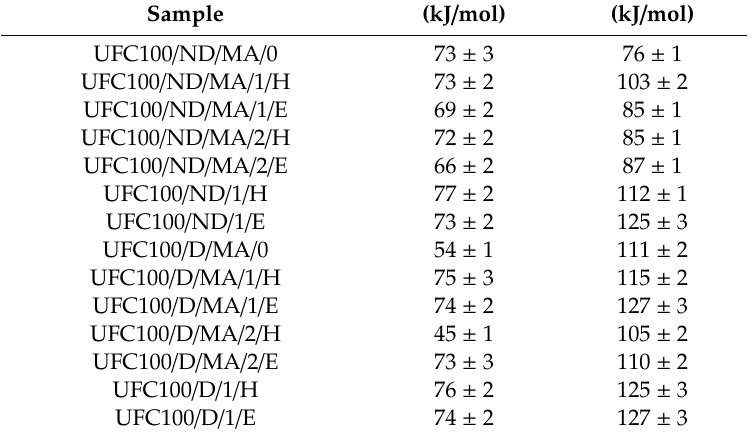
Table 7. Tabularized values of activation energy assigned to the decomposition steps calculated with the use of Broido’s method [42]; E A energy of cellulose thermal